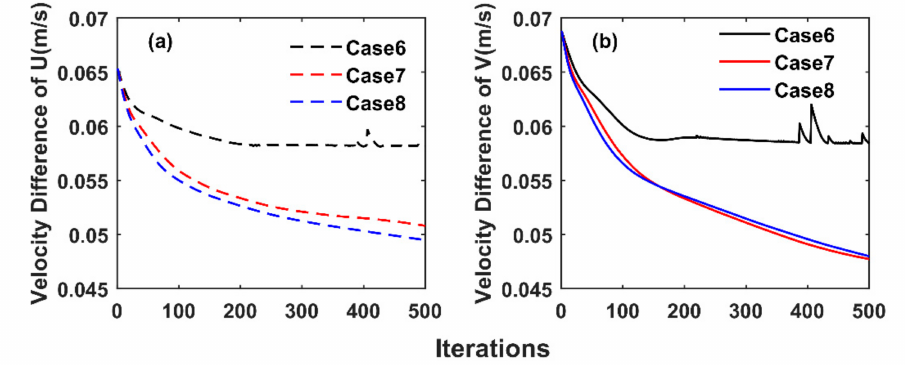
Figure 9. The MAEs of the current velocity components (U and V) between inversion results and observations. ( a ) is U direction, and ( b ) is V